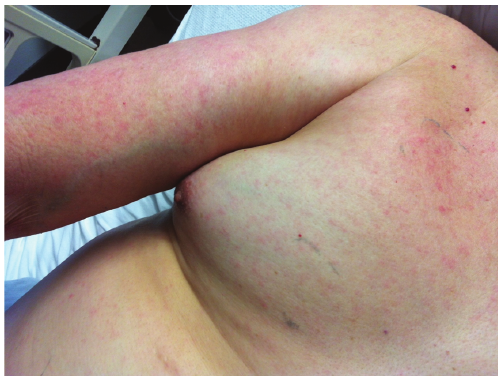
Figure 1: A light erythematous macular rash was noted on the chest and upper